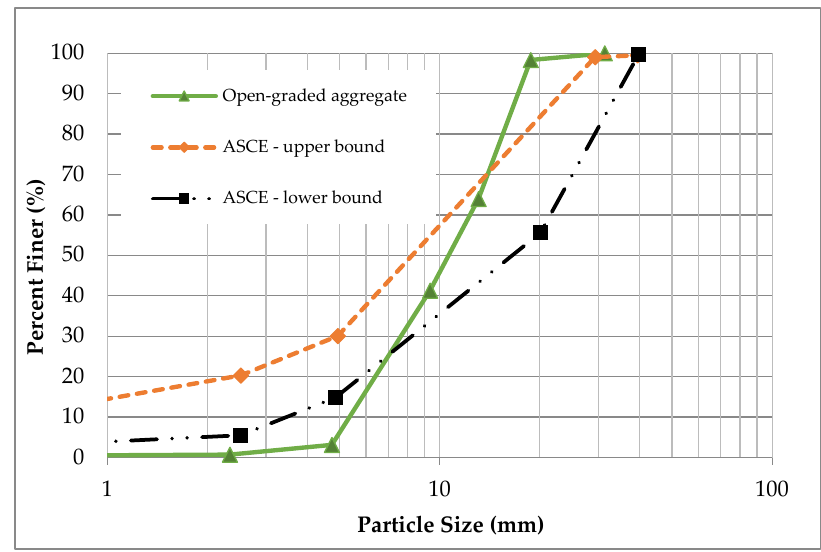
Figure 3. Aggregate gradation of the base layer. The geocell composites in this study comprised geocells and steel bars. The geocell was fabricated from high-density polyethylene (HDPE), with a height of 100 mm, a width of 300 mm, and a sheet thickness of 0.8 mm. To reduce the deformation of the geocells, steel bars with a diameter of 10 mm were used as a reinforcement. The first row of geocells was filled with concrete, with a compressive strength of 21 MPa, while the second row was filled with an open-graded material. By this way, the porous asphalt pavement not only allowed for water to infiltrate through the base layer, but also obtained a high mechanical performance. Figure 4 shows the geocell layer after filling with concrete and the open-graded aggregate material.